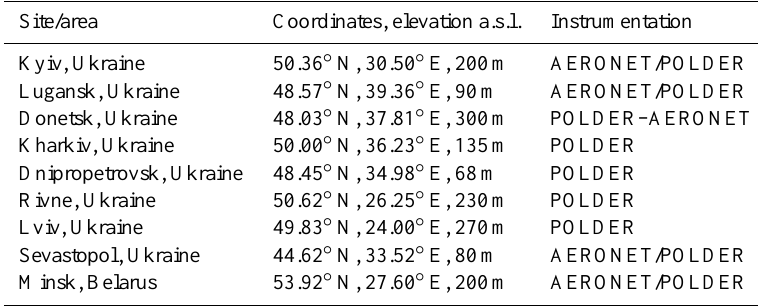
Table 1. AERONET sites and Ukrainian urban–industrial areas selected for